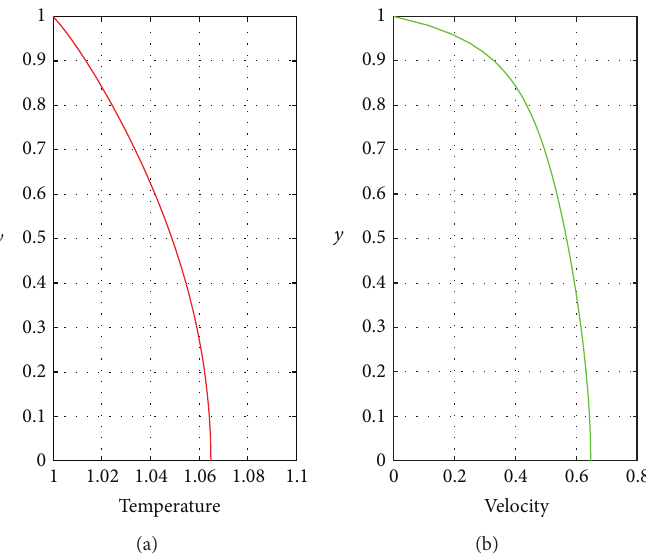
Figure 3: Velocity and temperature profiles at convergence; 𝑡 = 50 .